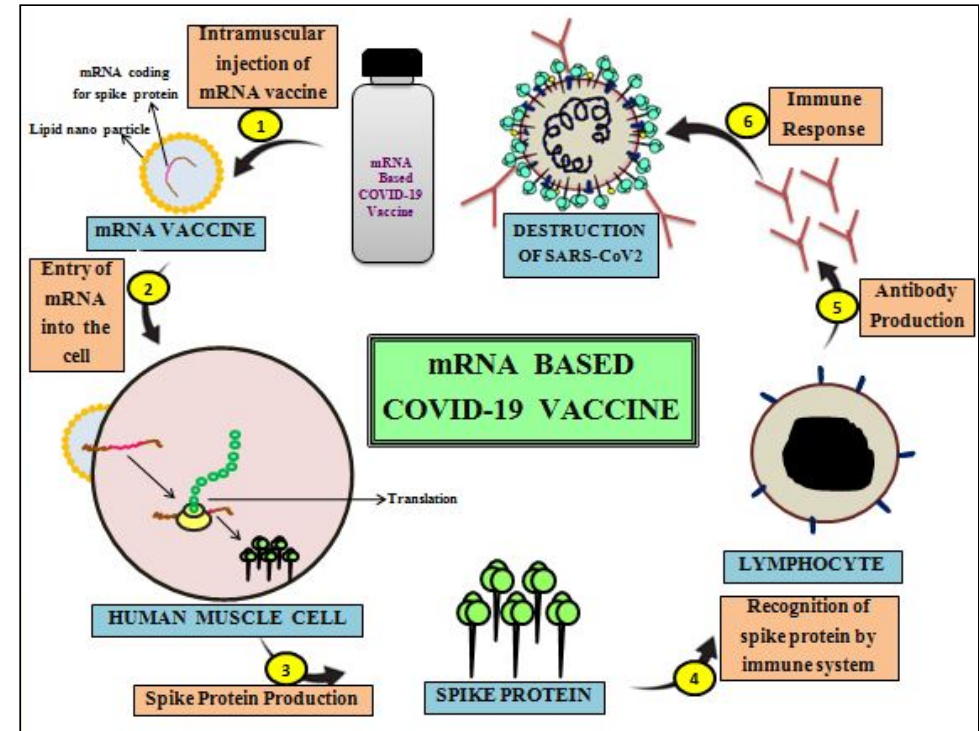
Figure 11. Mechanism of mRNA-based vaccine for developing immunity against COVID-19 infection: ( 1 ) intramuscular injection of mRNA-based vaccine; ( 2 ) entry and delivery of spike protein-encoding mRNA into human cells; ( 3 ) decoding of viral mRNA into spike protein and its display on the surface of human cells; ( 4 ) recognition of viral spike protein as antigenic determinant by immune cells; ( 5 ) immune cells’ production of antibodies (NABs) against viral spike proteins; ( 6 ) immune responses elicit antibodies to neutralize the SARS-CoV-2 virus in vaccinated